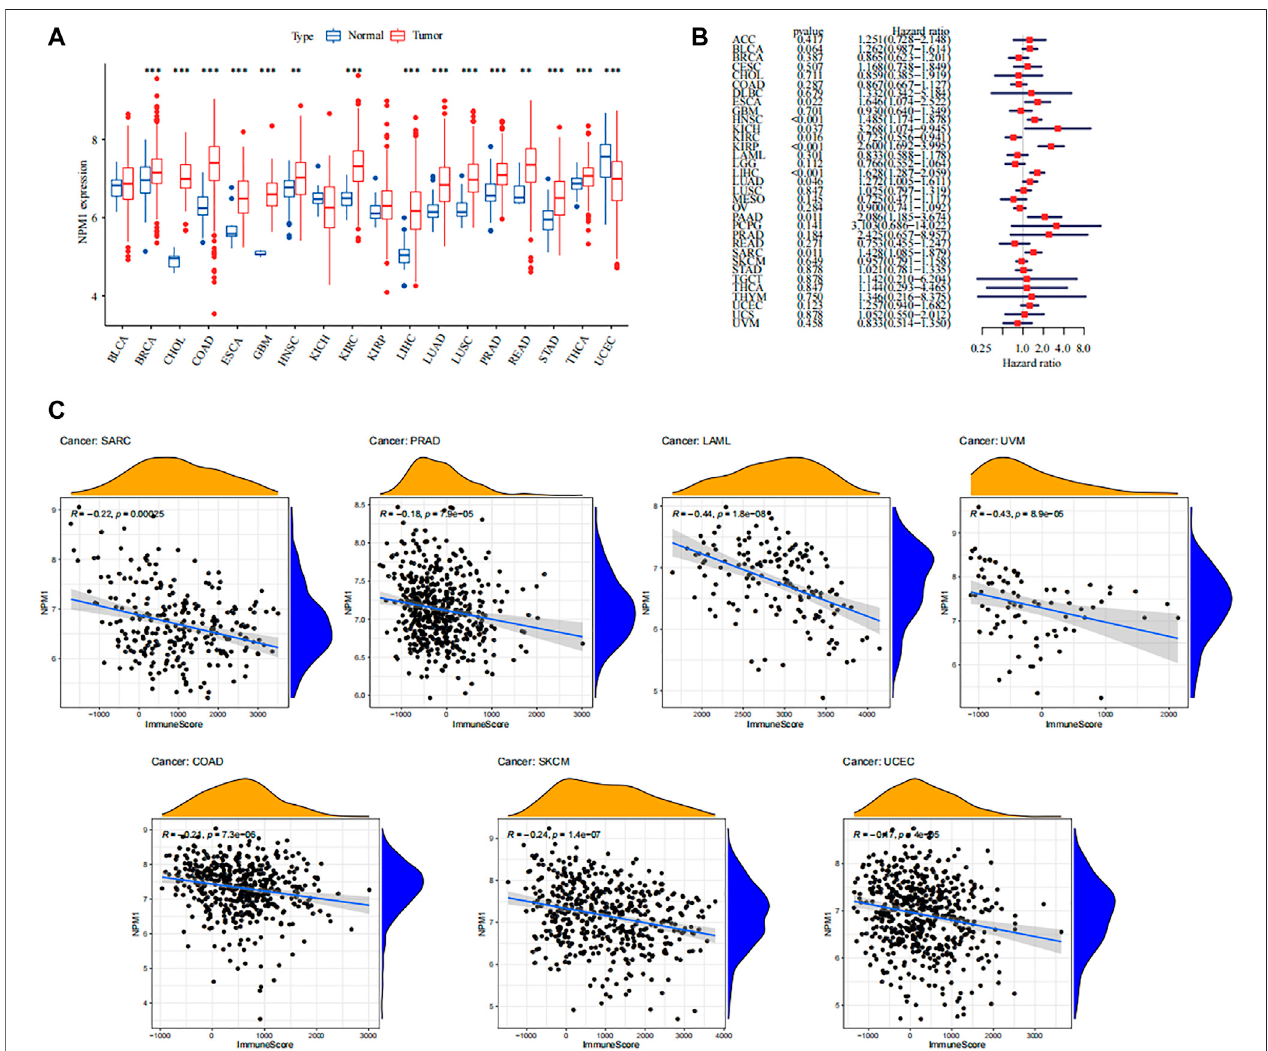
FIGURE 10 | Overview of NPM1 in human cancer. (A) The mRNA expression of NPM1 between tumor and normal control tissues wasassessed from The Cancer Genome Atlas (TCGA) database. (B) Univariate Cox regression analyses estimating prognostic value [overall survival (OS)] of NPM1 in different cancer types from TCGA database. (C) Association between immune scoring and NPM1 expression in multiple